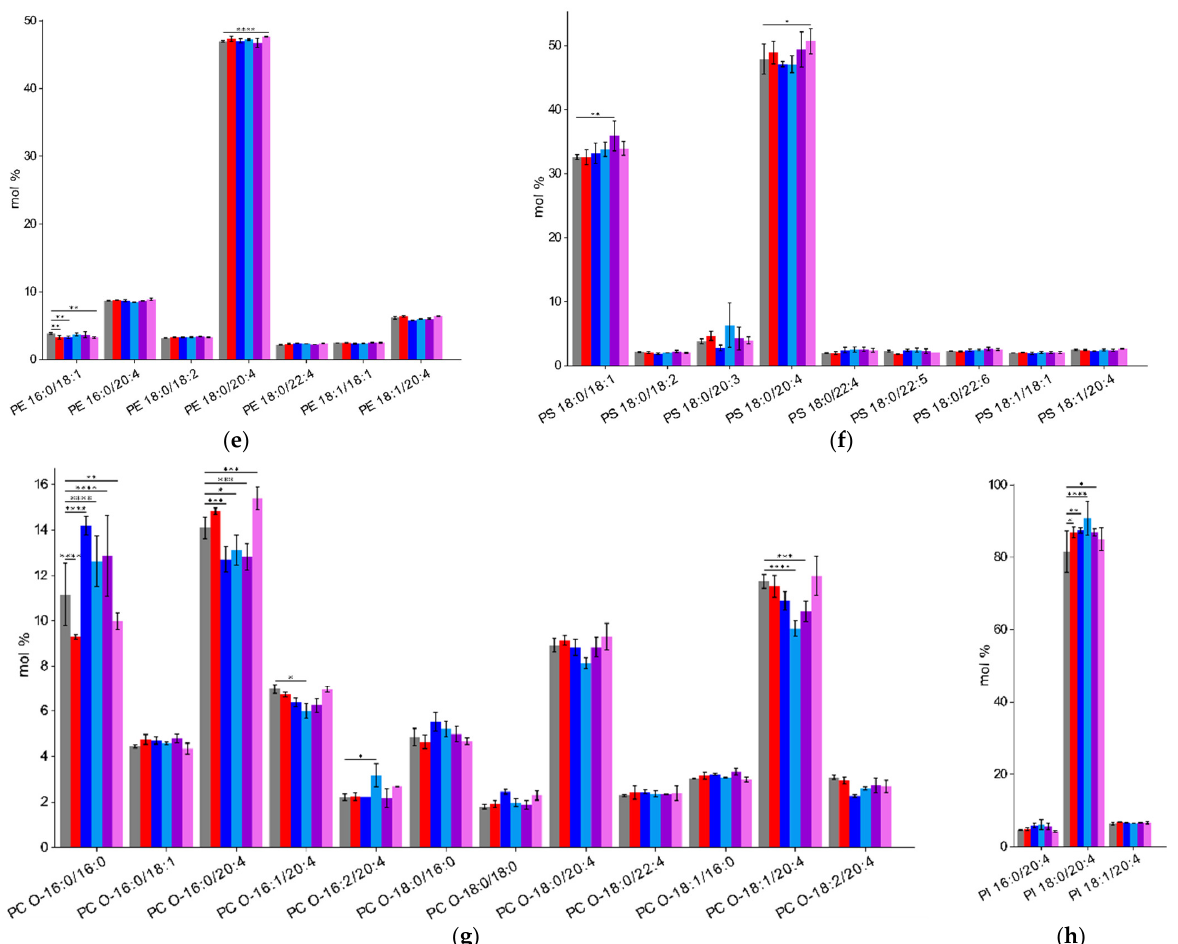
Figure 5. Composition of the platelet membrane. ( a ) Fatty acids species in the platelet plasma membrane represented by chain length and number of double bonds. The area of each circle is proportional to the abundance of each fatty acid in mol%. Subspecies which represent more than 2% of ( b ) phosphatidylcholines (PC), ( c ) phosphatidylethanolamines ether (PE O-), ( d ) sphingomyelins (SM), ( e ) phosphatidylethanolamines (PE), ( f ) phosphatidylserines (PS), ( g ) phosphatidylcholines ether (PC O-) and ( h ) phosphatidylinositols (PI). p -value was determined by a two-way ANOVA test (* = p < 0.05, ** = p < 0.01, *** = p < 0.005, **** = p < 0.001 versus the control group).